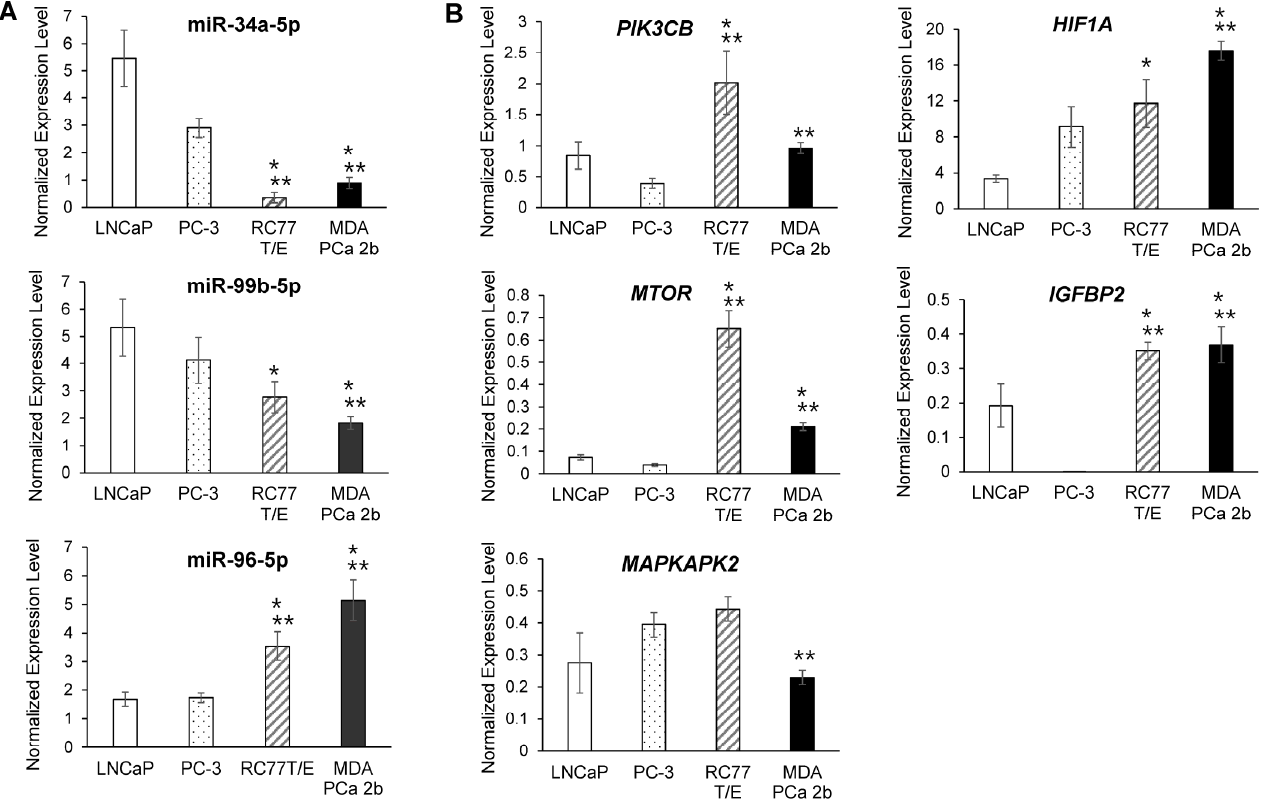
Figure 3. RT-qPCR validation of differentially expressed miRNAs and mRNAs in AA and EA PCa cell line models. ( A ) RT-qPCR assays for examining expression level of miR-34a-5p, miR-99b-5p and miR-96-5p in cell lines derived from EA PCa (LNCaP and PC-3) and AA PCa (RC77 T/E and MDA PCa 2b). ( B ) RT-qPCR assays for examining expression level of PIK3CB , MTOR , HIF1A , IGFBP2 and MAPKAPK2 in AA and EA PCa cell line models. Data were presented as mean ± SEM of n = 4-6 independent experiments, with technical triplicates for each independent experiment. The significance (* p < 0.05 in AA PCa cell line vs. LNCaP, and ** p < 0.05 in AA PCa cell line vs. PC-3) was determined based on ANOVA with Tukey post hoc test.